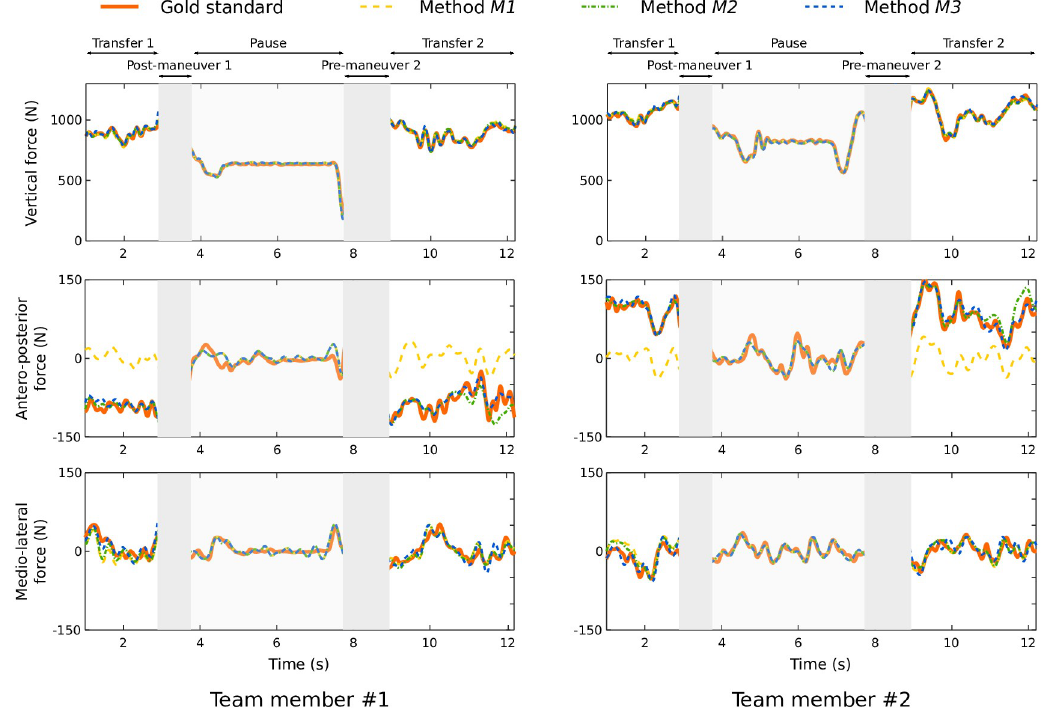
Fig 5. Representative example of predicted and measured GRF. The three graphs on the left represent team member ] 1’s GRF and the three graphs on the right represent team member ] 2’s GRF. The orange curves represent the gold standard, the yellow curves M1 , the green curves M2 and the blue curves M3 . The different areas of the trial are highlighted: the handling phases are the ones with no background shading (areas on the left and on the right of each graph); these areas were taken into account in the statistics. The central area represents the break between two handling tasks. The phases shaded in gray are manipulation phases (pre-grip and post-deposit); these phases were not taken into account by the prediction methods.